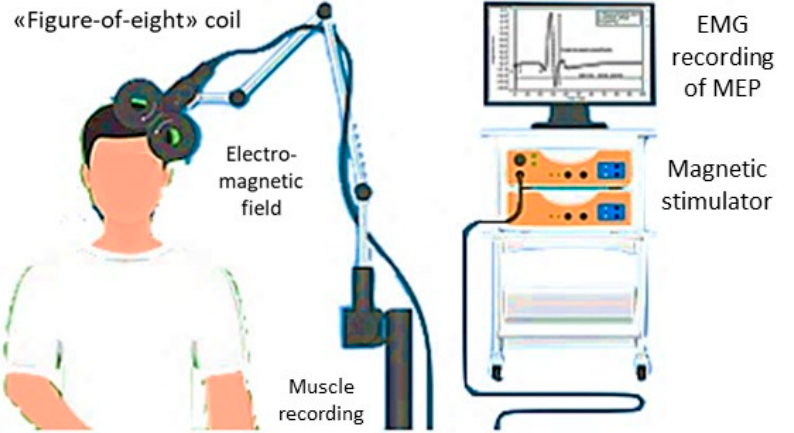
Figure 2. Basic principles and running of a standard TMS exam; an example of MEP in the screen. EMG: electromyiographic; MEP: motor evoked potential. EMG: electromyiographic; MEP: motor evoked